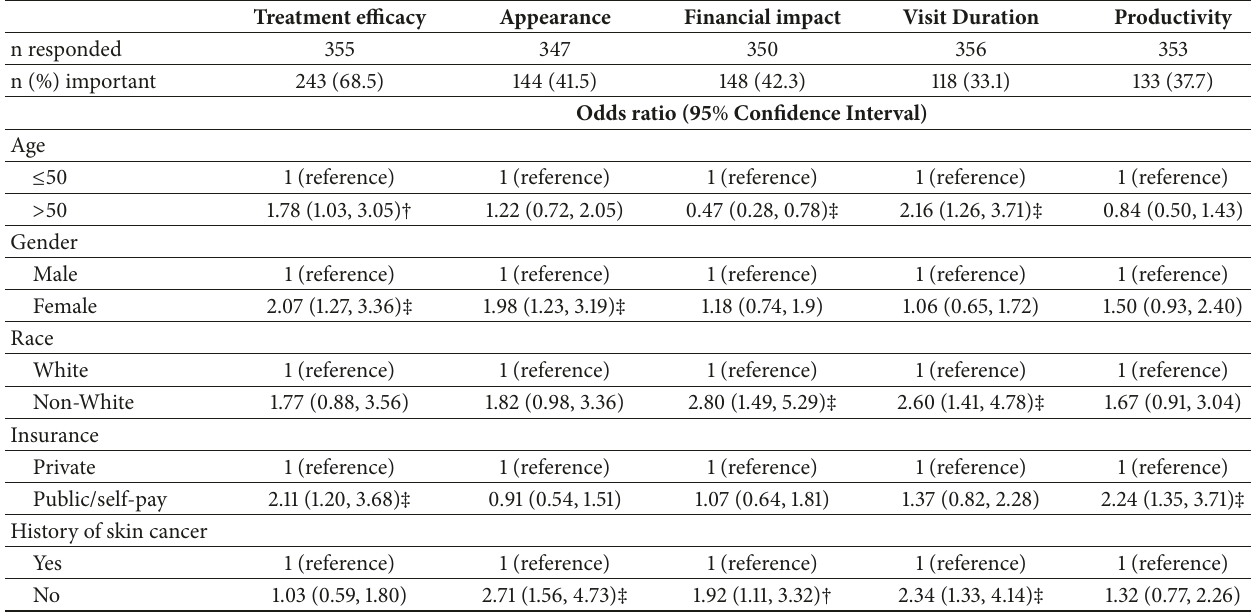
Table 2: Adjusted odds ratios for patient characteristics associated with preferences about treatment approaches of skin